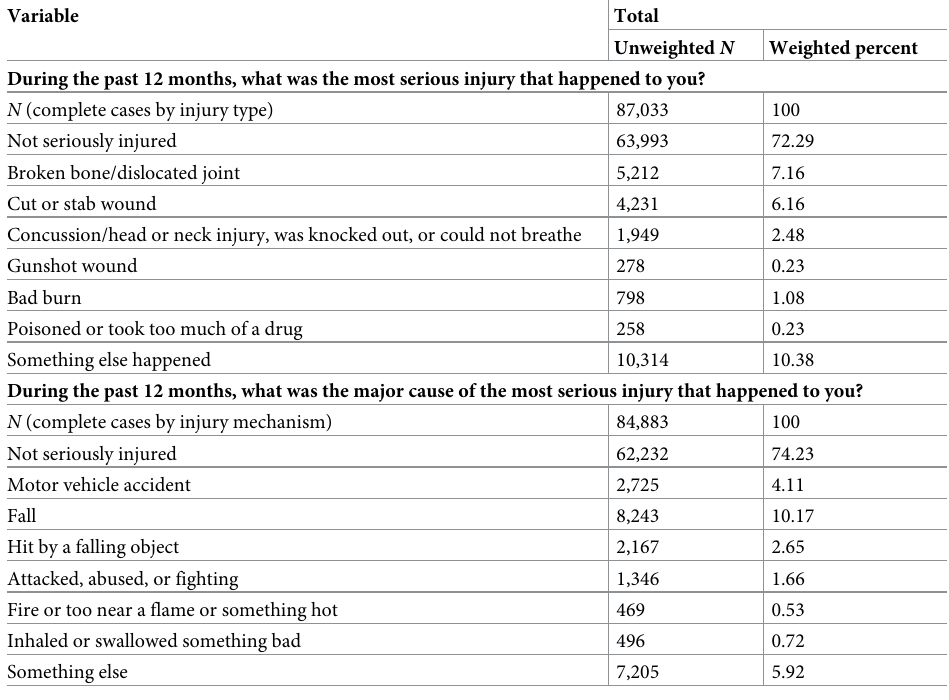
Table 4. Number of serious injuries by type and mechanism (numbers of cases used for this analysis and their characteristics are shown in Tables E–H in S1 Text). Variable Total